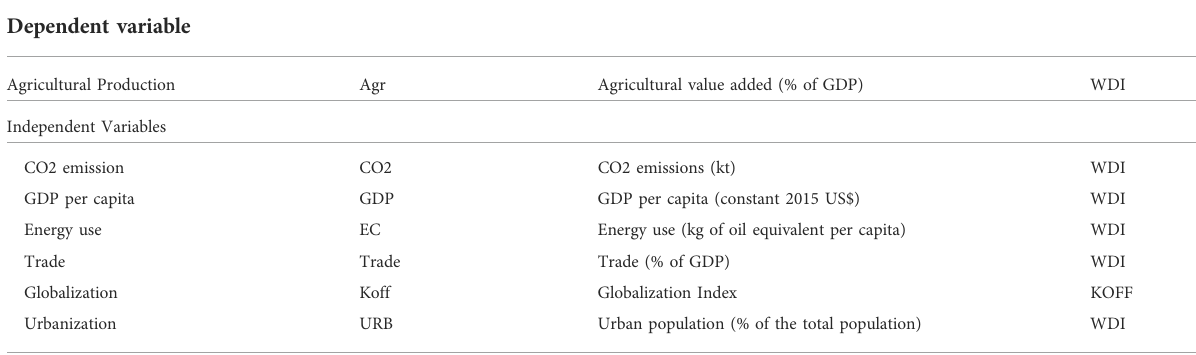
TABLE 1 Variable Description and Data